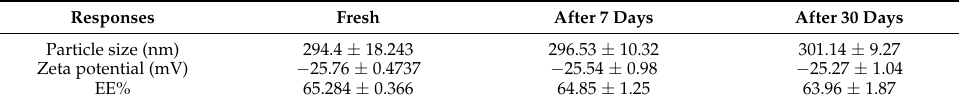
Table 4. The effect of storage at 4 ◦ C for one month on particle size, zeta potential, and EE% of the optimum formula.